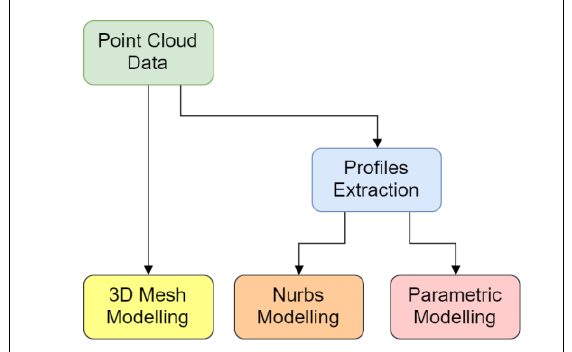
Figure 4. In common workflow every new object requires a new modelling process from the scratch